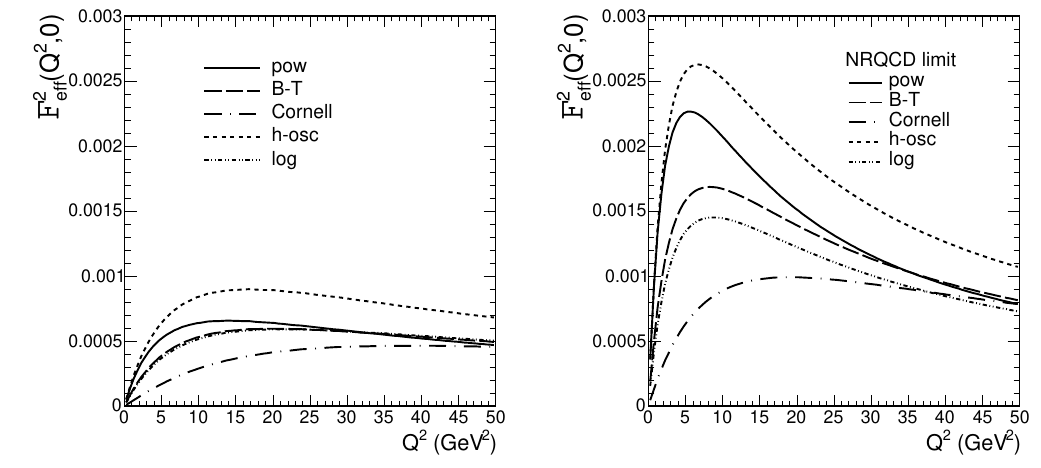
Figure 7 . The square of the effective form factor eq. (4.16) as a function of photon virtuality within LFWF approach (on the l.h.s.) and in the nonrelativistic limit (on the